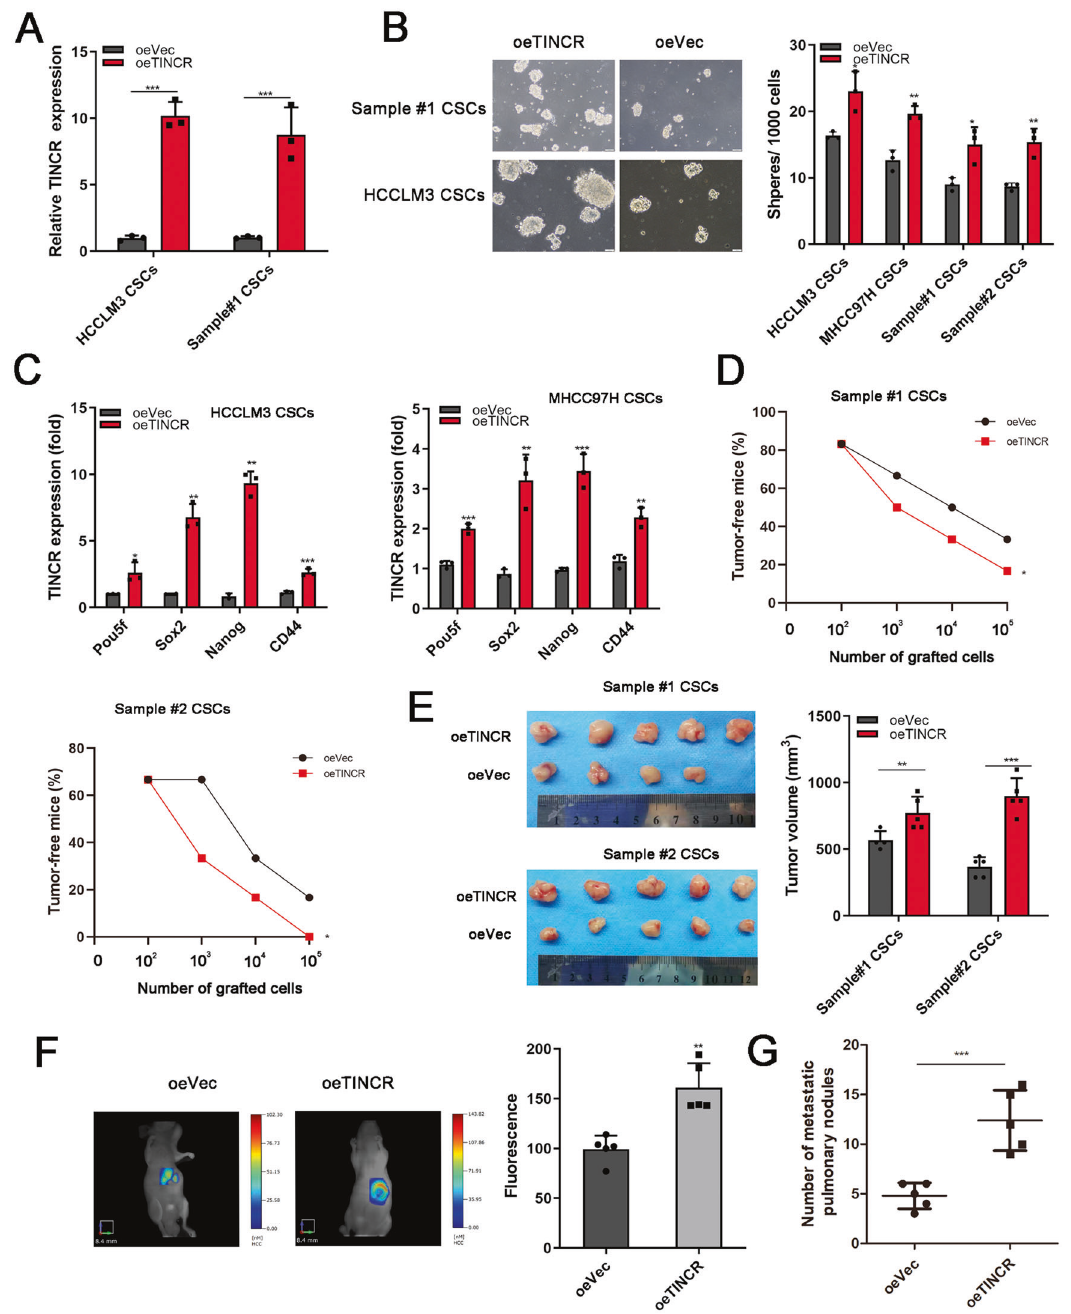
Fig. 3 Overexpressed TINCR enhanced tumorigenic capacity of LCSCs. A TINCR stably overexpressed HCC primary tumor cells and cell lines were established. (B) TINCR overexpression promoted sphere formation of HCC cell lines and primary cells. Scale bar, 100 mm. C Expression of transcription factors were elevated in TINCR-overexpressing HCC cells. D TINCR overexpressed primary tumor cells were diluted and subcutaneously implanted into BALB/c mice. n = 6 for each group. (E) After subcutaneous implantation, the average tumor volumes in each groups were calculated. F Fluorescence signals of liver orthotopic tumor from TINCR-overexpressing and empty vector groups were captured. G TINCR-overexpressing promoted lung metastasis rate. Data are shown as means ± SD. * p < 0.05, ** p < 0.01, *** p < 0.001. staining (HE) images con fi rmed that knockdown of TINCR signi fi cantly attenuated pulmonary metastasis (Fig. 2I). Overall, TINCR silencing reduced the tumorigenic capacity of LCSCs. TINCR overexpression enhanced tumorigenic capacity of LCSCs We next established TINCR stably overexpressing HCC primary tumor cells and cell lines (Fig. 3A). Overexpressed TINCR promoted 3E). Consequently, TINCR